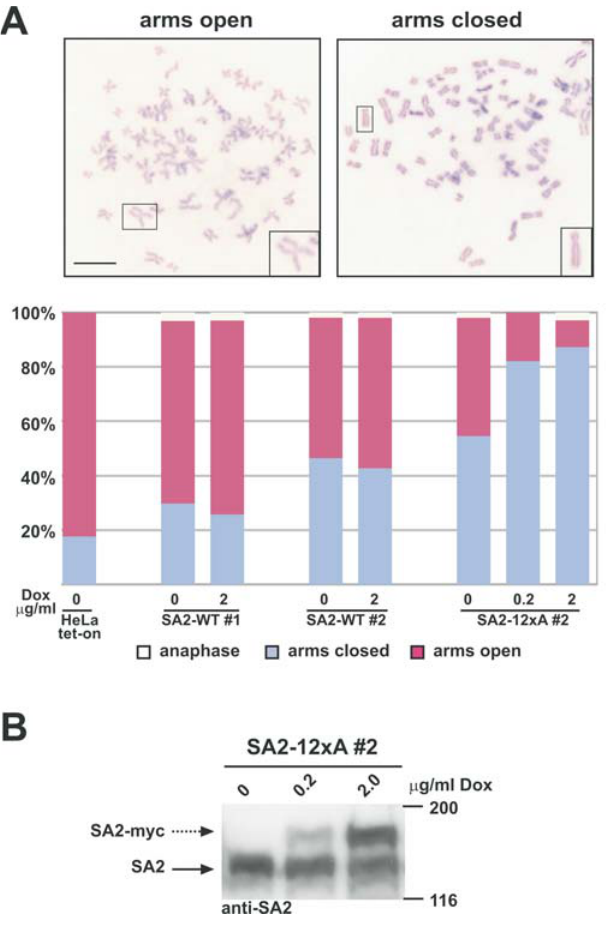
Figure 6. The Presence of SA2–12xA on Chromosome Arms Correlates with Cohesion between Sister Chromatid Arms (A) Cells were cultured in the absence or presence of different amounts of doxycycline as indicated. After arrest in nocodazole for 3 h, cells were fixed, spread on glass slides, and stained with Giemsa (photomicrographs, above). Single chromosomes (indicated by a box) are shown at higher magnification in the lower right corners. The number of cells with chromosome arms that had opened (arms open) or that were connected (arms closed) was scored as indicated (bar graphs, below). Scale bar 10 l m. (B)Whole-cellextractswerepreparedfromHeLacellsexpressingSA2– 12xA-myc after treatment with increasing amounts of doxycycline (0, 0.2, and 2.0 l g/ml). The ratio of exogenous SA2–12xA-myc to endog- enous SA2 was visualized by immunoblotting with antibodies to SA2. The position of molecular weight markers is indicated on the right. DOI: 10.1371/journal.pbio.0030069.g006